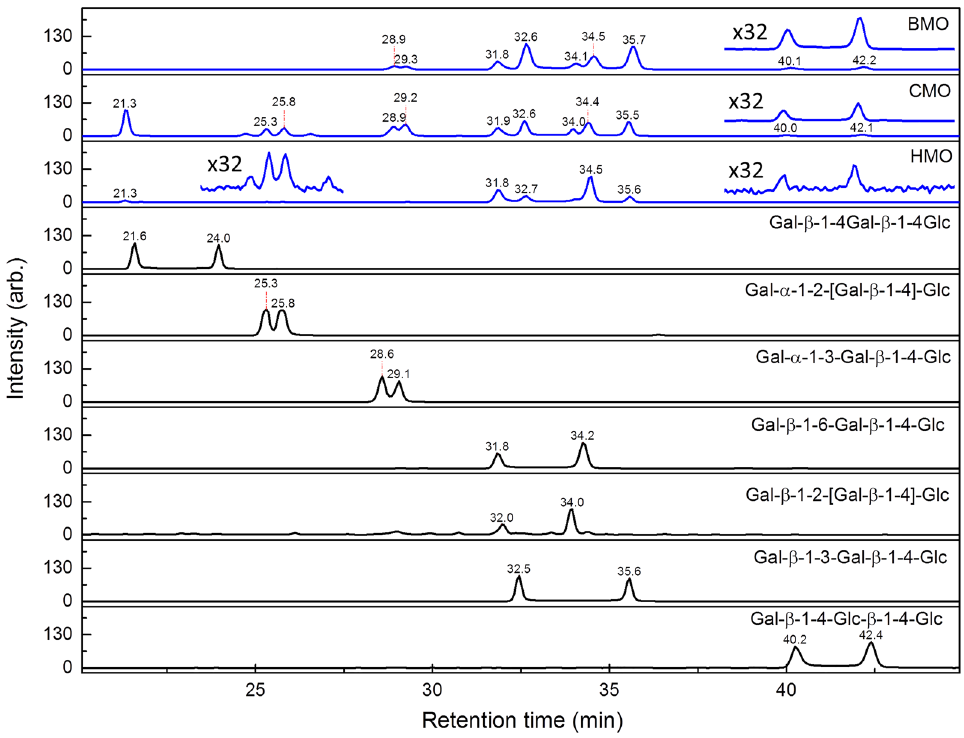
Figure 3. Chromatograms of ion m/z 527, sodium adducts of (Hex) 3 , of human milk oligosaccharides (HMO), bovine milk oligosaccharides (BMO), caprine milk oligosaccharides (CMO), and various chemically synthesized (Hex) 3